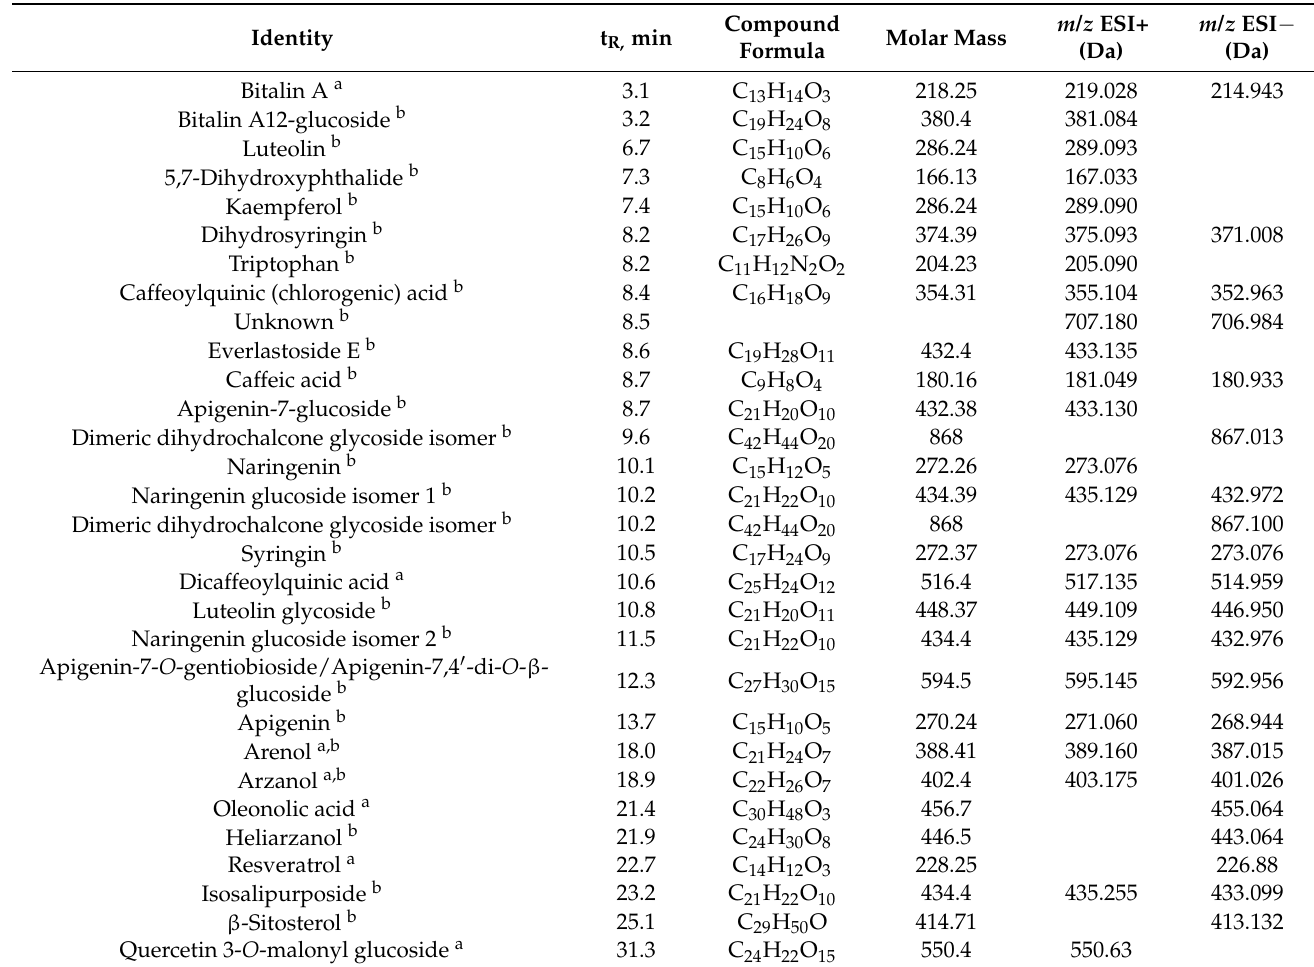
Table 2. Tentative identification of compounds in H. arenarium inflorescence and leaf extracts analyzed by